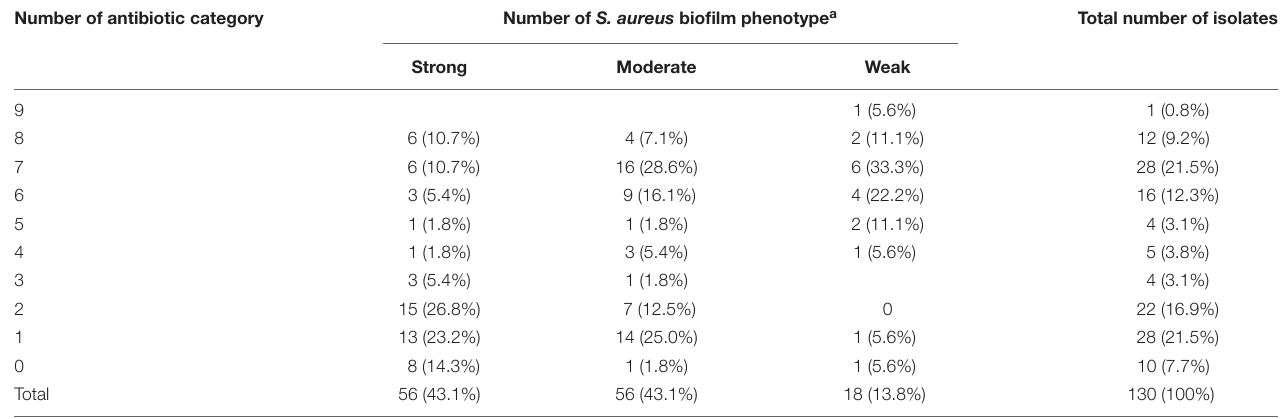
TABLE 7 | Occurrence of multidrug resistant pattern and their associations with biofilm phenotype in 130 S. aureus from different stages of pork production. Number of antibiotic